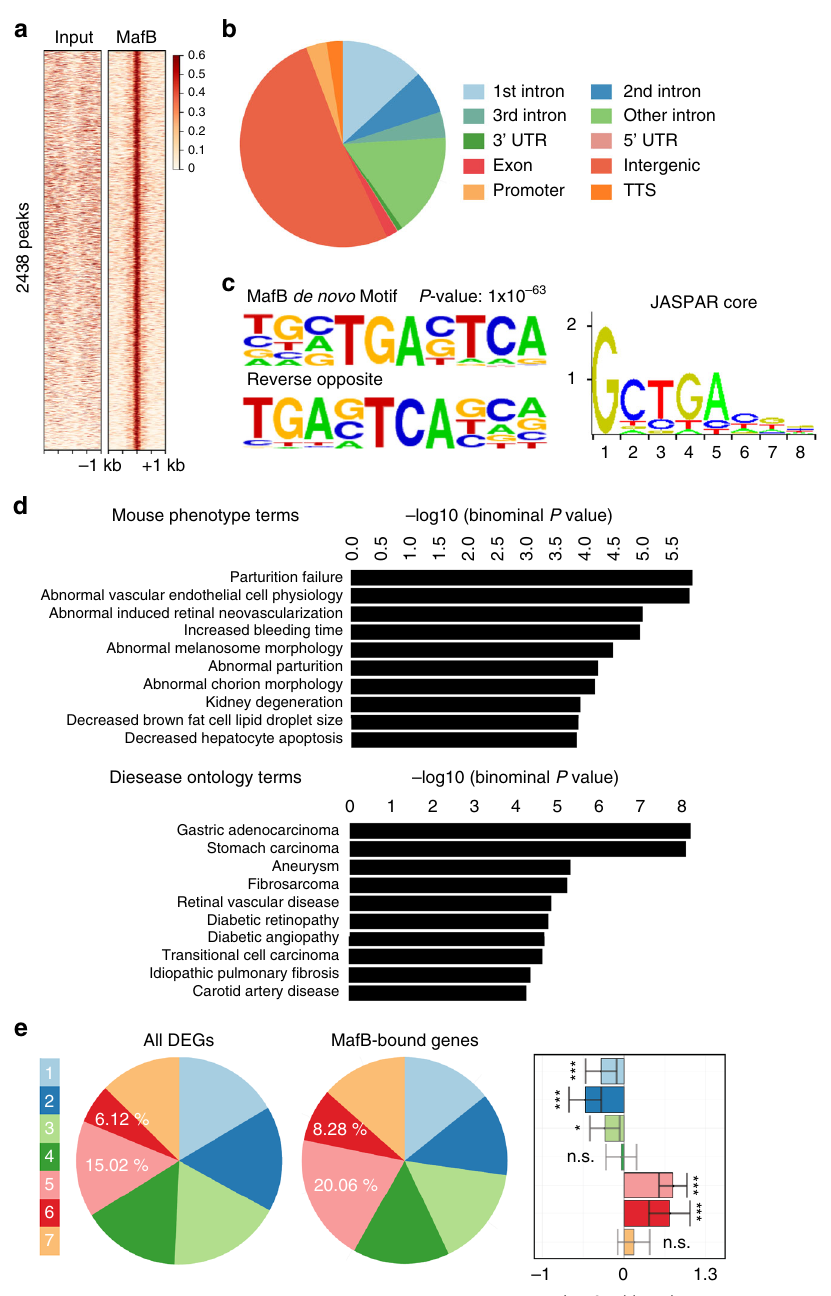
Fig. 6 ChIP-Seq analysis of MafB in ECs. a , b Heat map of 2438 peaks of MafB ChIP-Seq with input ( a ) and distribution of MafB peaks across the genome ( b ). Color scale corresponds to reads per million mapped reads in 20 bp bins. c MafB de novo motif identi fi ed by HOMER with JASPAR MafB ( Rattus norvegicus ) motif. d Enriched mouse phenotype terms ( top ) and disease ontology terms ( bottom ) for genes associated with MafB in the context of ECs. e Association between MafB-bound genes and retinal clusters of differential gene expression (Fisher ’ s exact test with FDR adjustment for multiple testing; ns, not signi fi cant; * q -value < 0.05; ** q -value < 0.01; *** q -value <